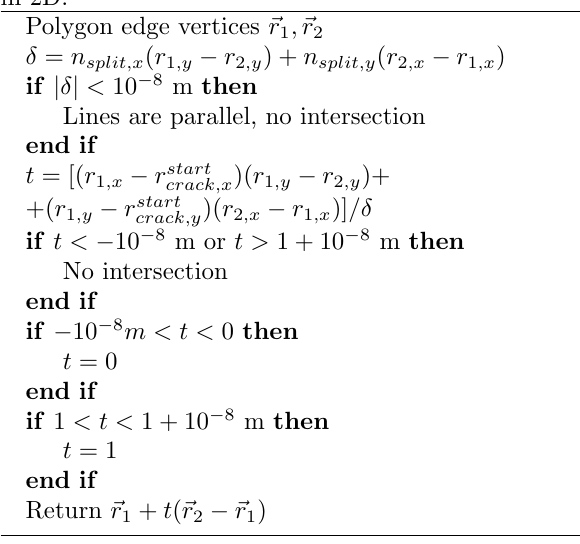
Algorithm 8 Polygon edge - splitting ray intersection